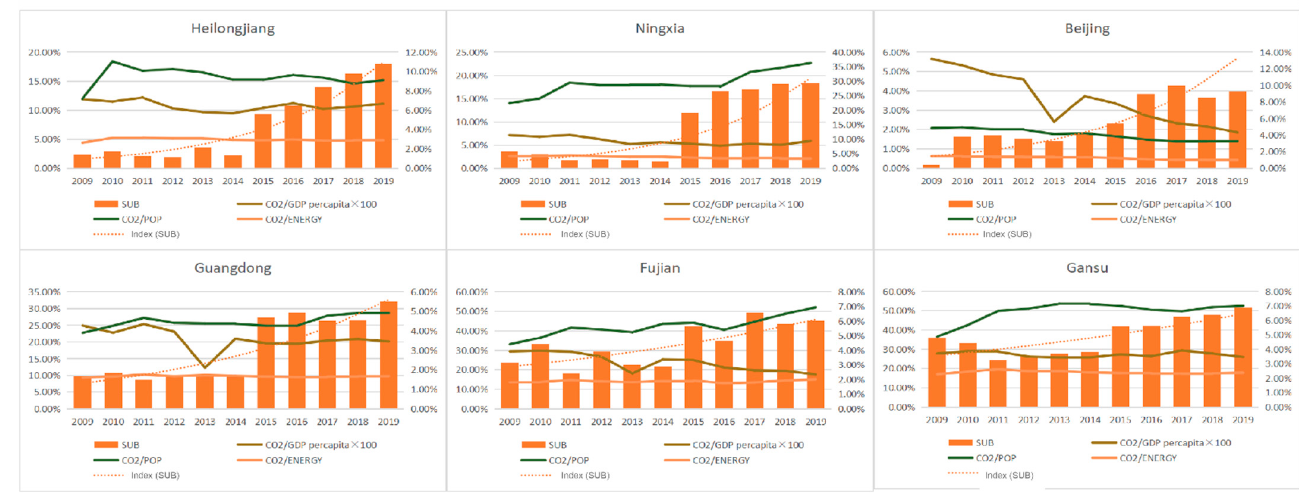
Figure 6. The Carbon Emission and SUB change across 30 provinces in China (2009–2019).